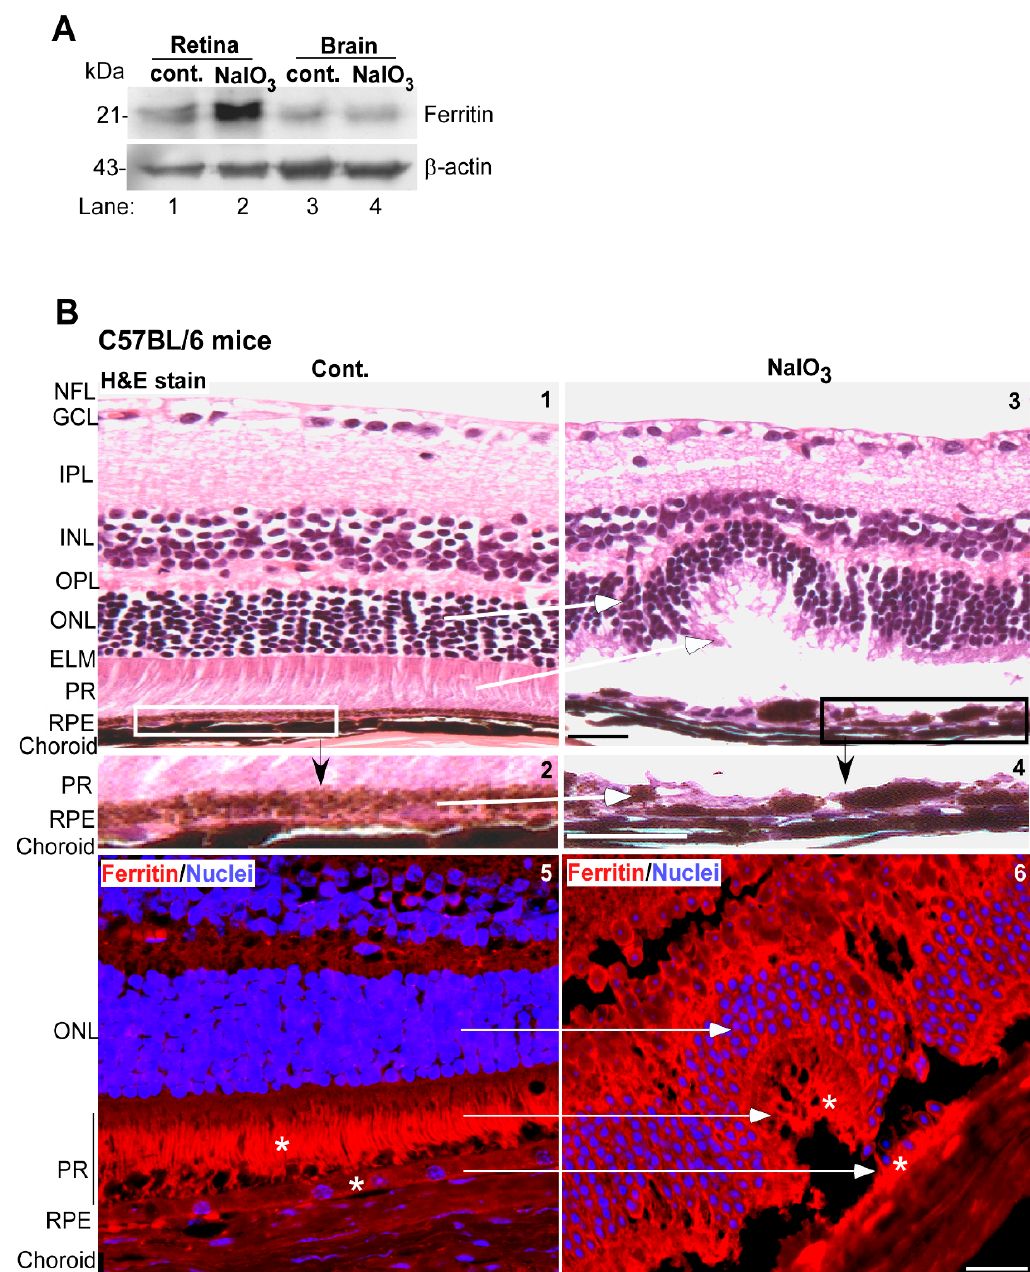
Figure 5. NaIO 3 upregulates ferritin and disrupts retinal cell layers in mouse models. ( A ) Probing of retinal and brain lysates from NaIO 3 and control mice for ferritin showed significantly higher levels in retinal samples (lane 2 vs. 1) relative to controls. Brain samples from the same mice showed a similar level of ferritin (lane 4 vs. 3). (Tissue from 5 mice was pooled for this experiment). The membranes were re-probed for β -actin as a loading control. Full blots and their details are provided in Supplementary Figure S1. ( B ) Hematoxylin and Eosin (H&E) staining of mouse retina showed well-defined layers in control mice (panel 1). The boxed area is enlarged in panel 2. Mice administered NaIO 3 showed disruption of the RPE and photoreceptor cell layers (panel 3). Scale bar: 25 µm. The boxed area is enlarged in panel 4. Scale bar: 25 µm. Immunoreaction for ferritin showed increased expression in the RPE and photoreceptor cell layers of NaIO 3 -treated mice relative to controls (panel 6 vs. 5, marked by *). Scale bar: 25 µm. A serial section treated with rabbit IgG and Alexa Fluor 546-conjugated secondary antibody (red) showed no reaction (Supplementary Figure S3). RPE: retinal pigment epithelium; PR: photoreceptors; ELM: external limiting membrane; ONL: outer nuclear layer; OPL: outer plexiform layer, INL: inner nuclear layer, IPL: inner plexiform layer, GCL: ganglion cell layer; NFL: nerve fiber layer.